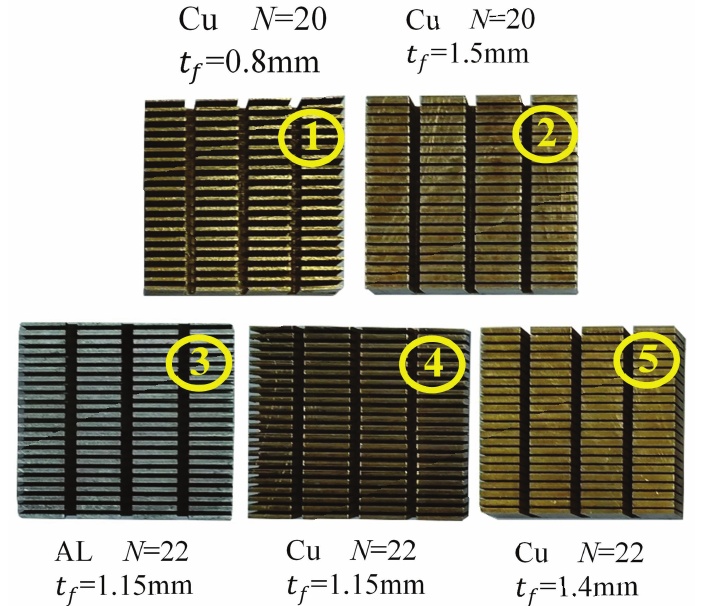
Figure 12. Five customized heat sinks.